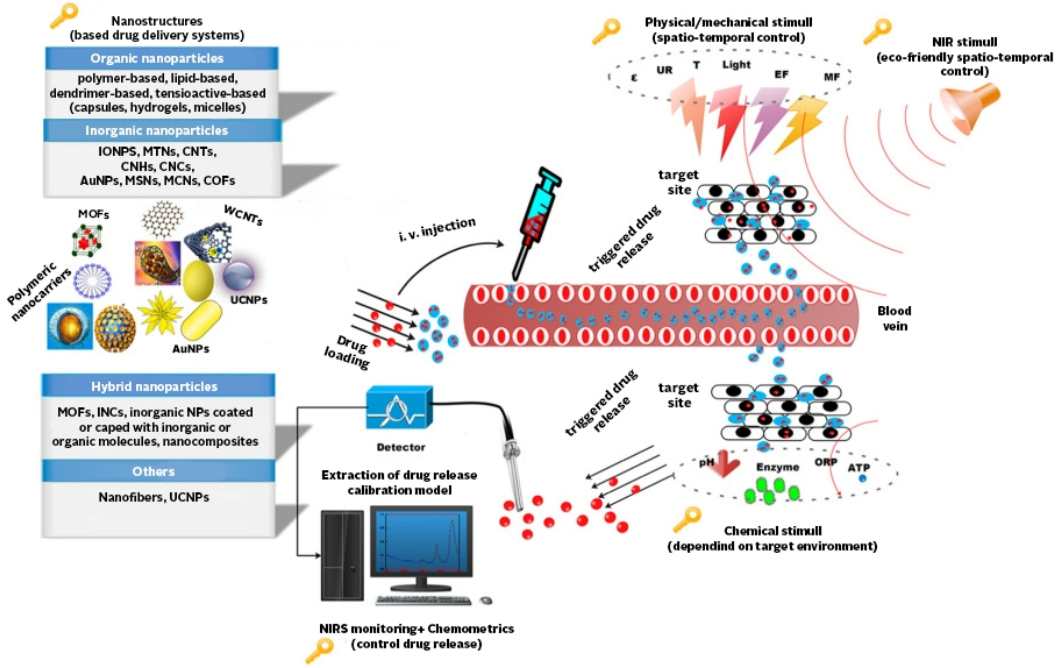
Figure 2. Scheme of basic nanostructures for DDS and different stimulation. Adapted with permission from [60], Elsevier, 2017.